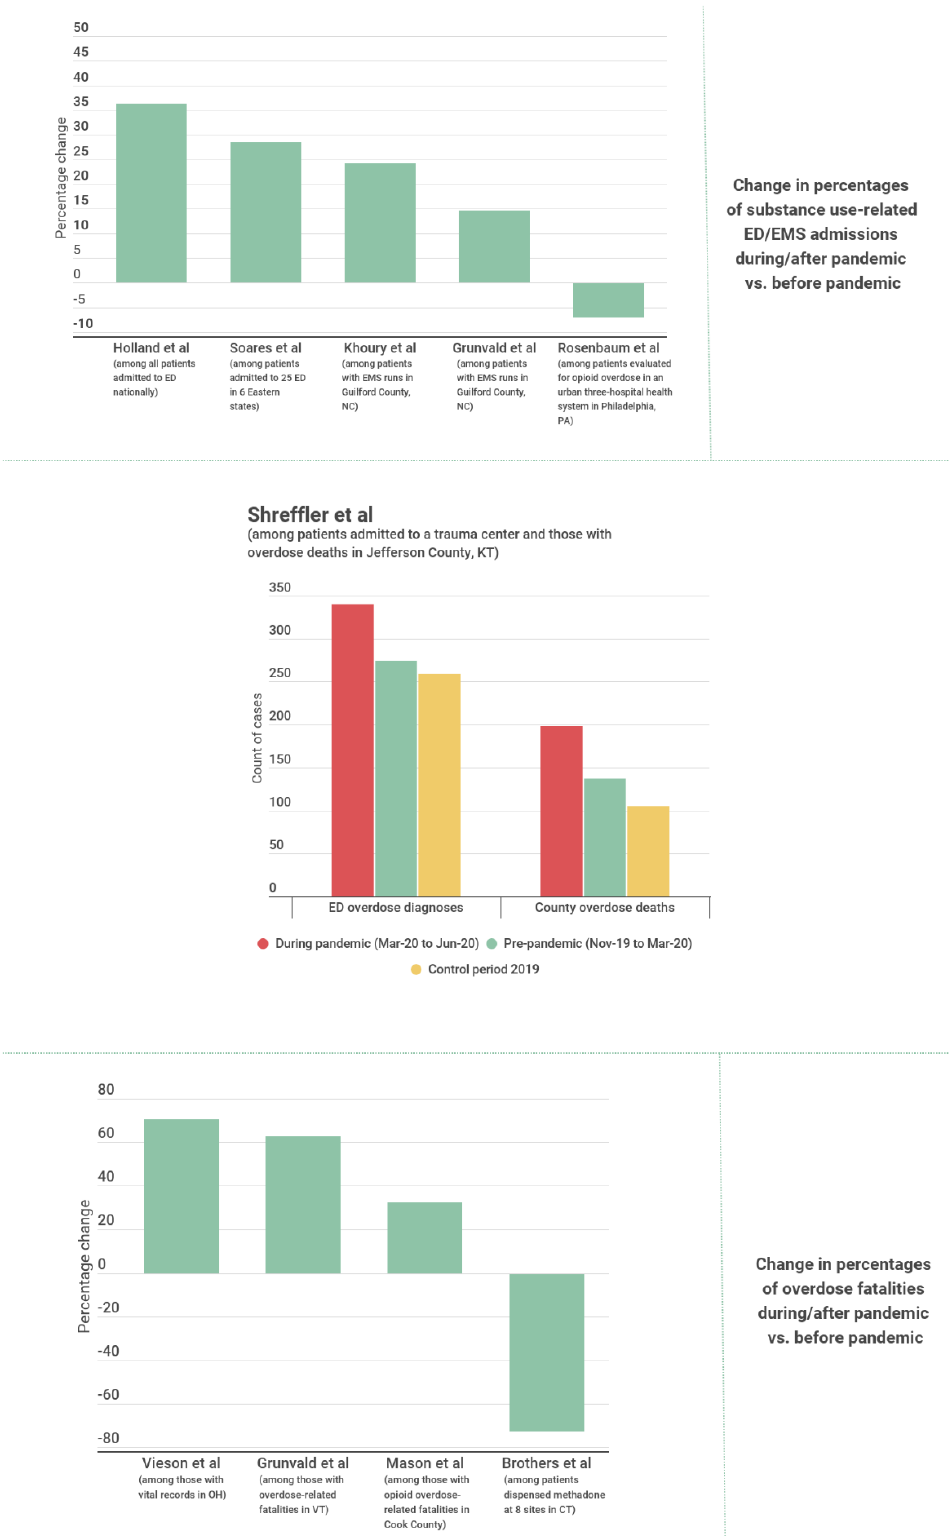
Figure 7. Summary evidence for substance use-related health outcomes. ED= Emergency Department. EMS= Emergency Medical Services. NC = North Carolina. PA = Philadelphia. KT = Kentucky. OH = Ohio. CT = Connecticut. VT = Vermont [39,48,51,53 – 56,59,60].